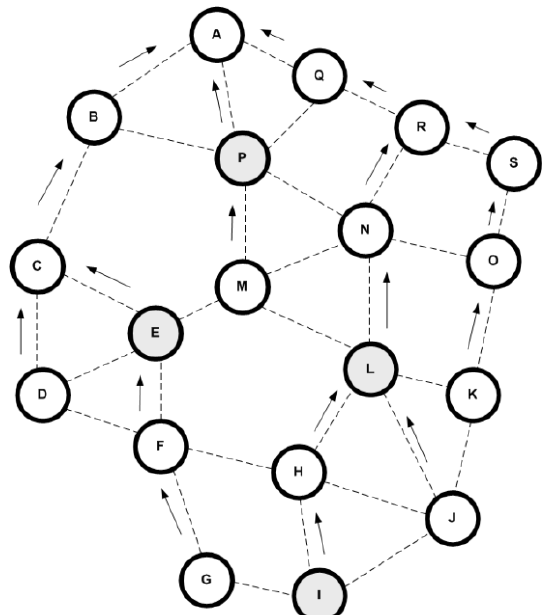
Figure 13. Data aggregation in